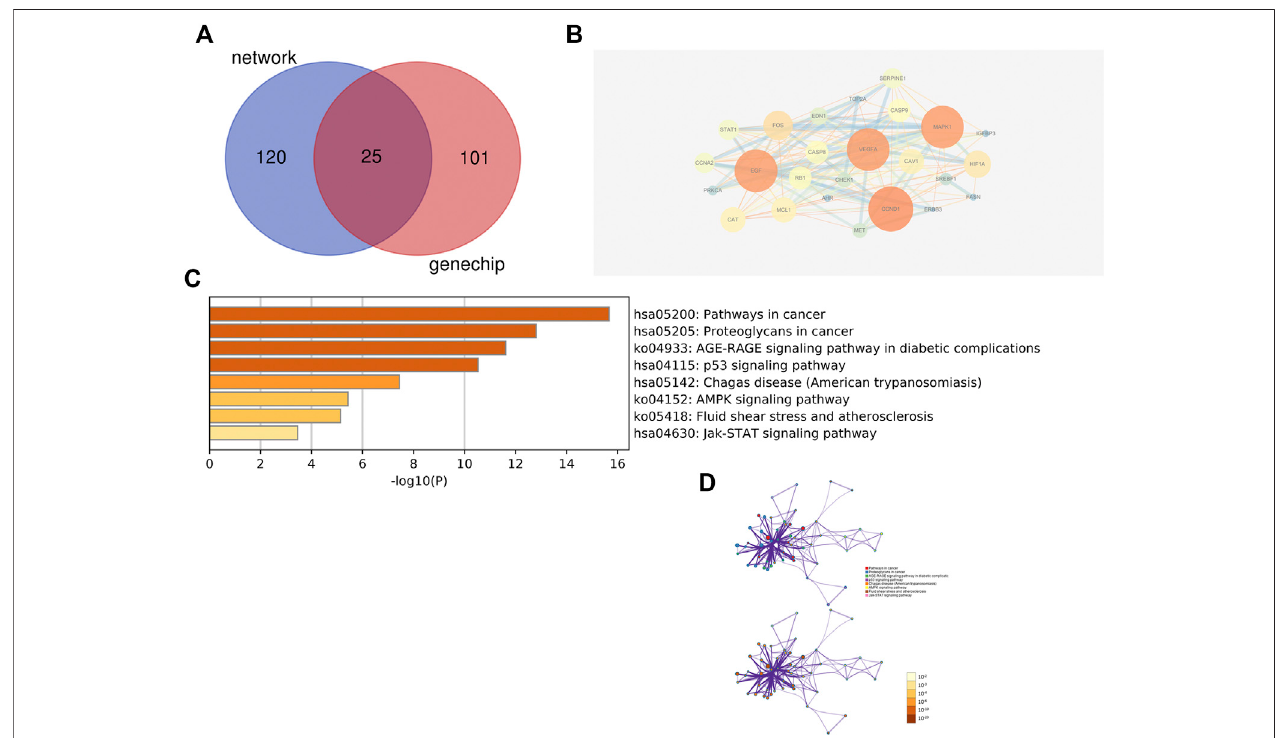
FIGURE6 | Identical results of systems pharmacology and gene chip model. Notes: (A) : The intersection oftwo models predicted targets and livercancertargets. (B) : PPI network of intersection ’ s targets. (C) : Pathways involved in intersection ’ s targets. (D) : Distribution and signi fi cance of target proteins in pathway C.